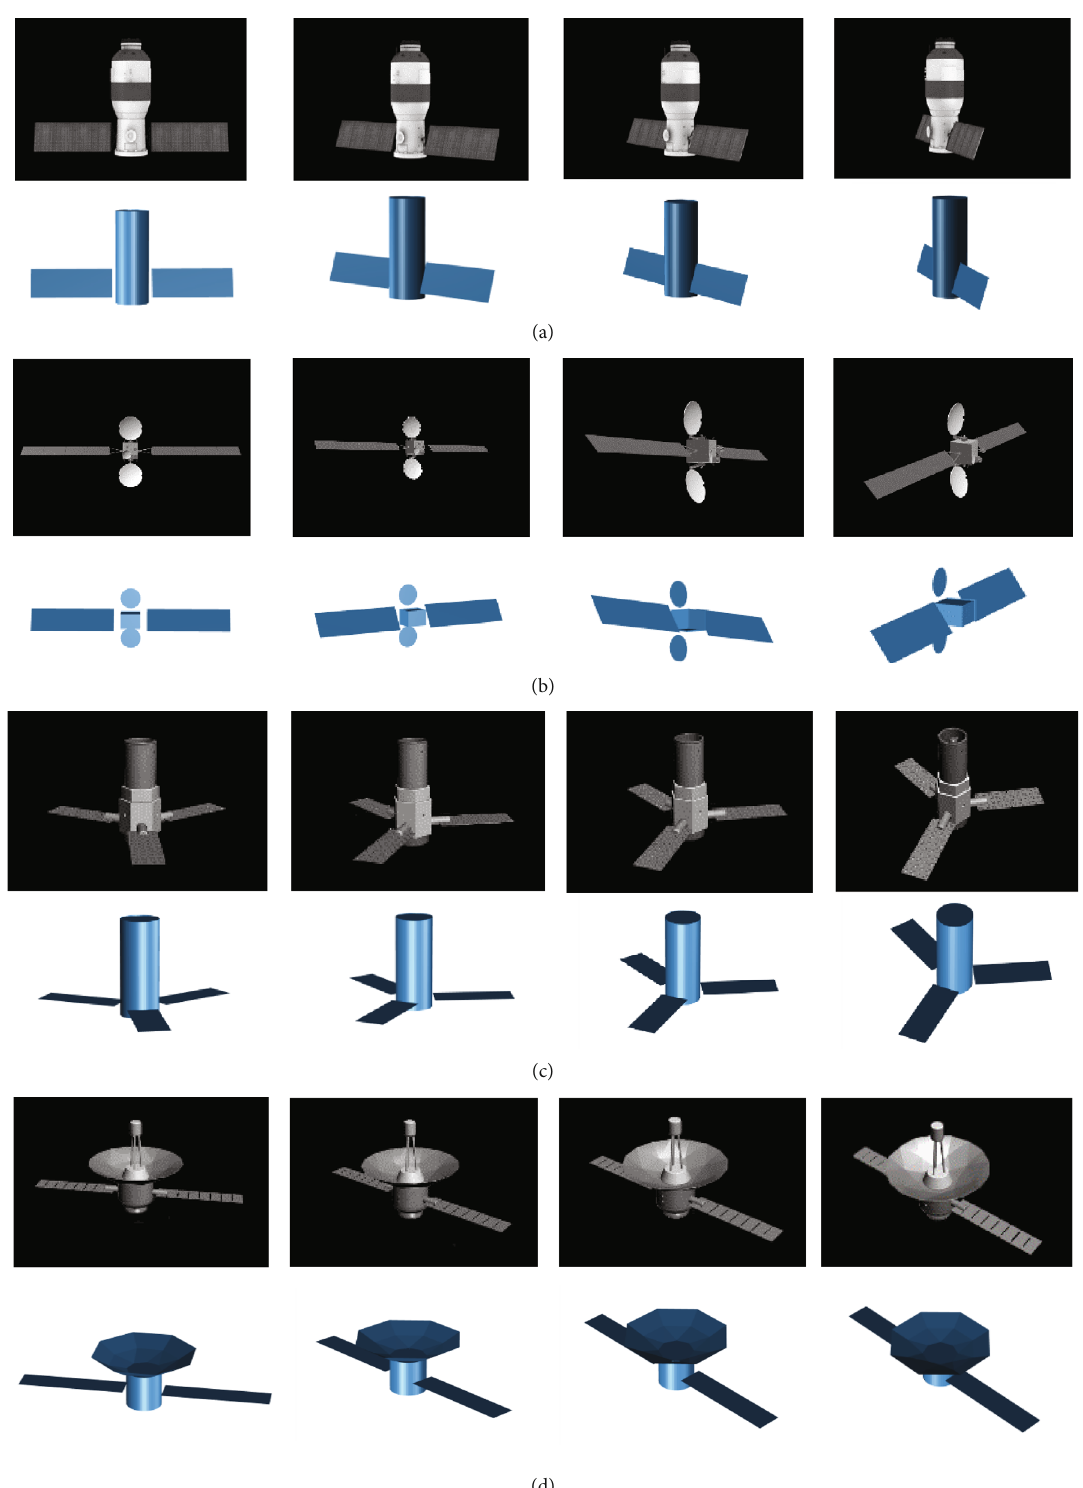
Figure 7: Part of the qualitative results of pose estimation of unknown space objects. The bottom of each test image is the object shape inferred by our method under the estimated pose. Four objects are arranged in sequence from (a) to